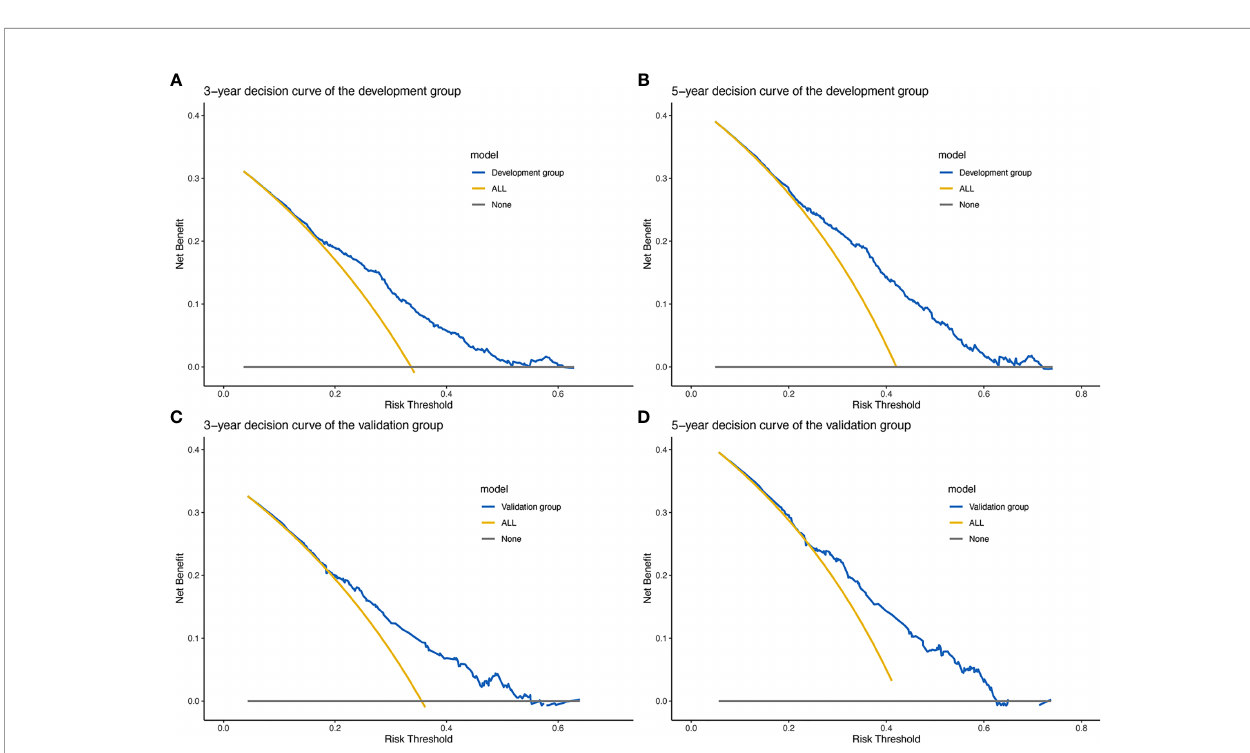
FIGURE 5 | Prognostic decision curve analysis (DCA) of patients with WHO Grade III meningioma. (A) 3-year survival DCA of the development set; (B) 5-year survival DCA of the development set; (C) 3-year survival DCA of the validation set; (D) 5-year survival DCA of the validation set.